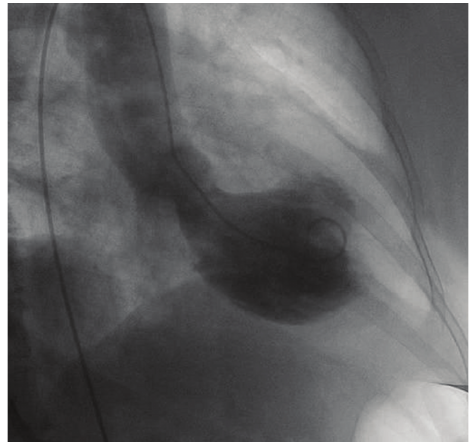
Figure 3: Left ventriculogram showing apical and basal hyperkine- sis and mid cavitary akinesis.